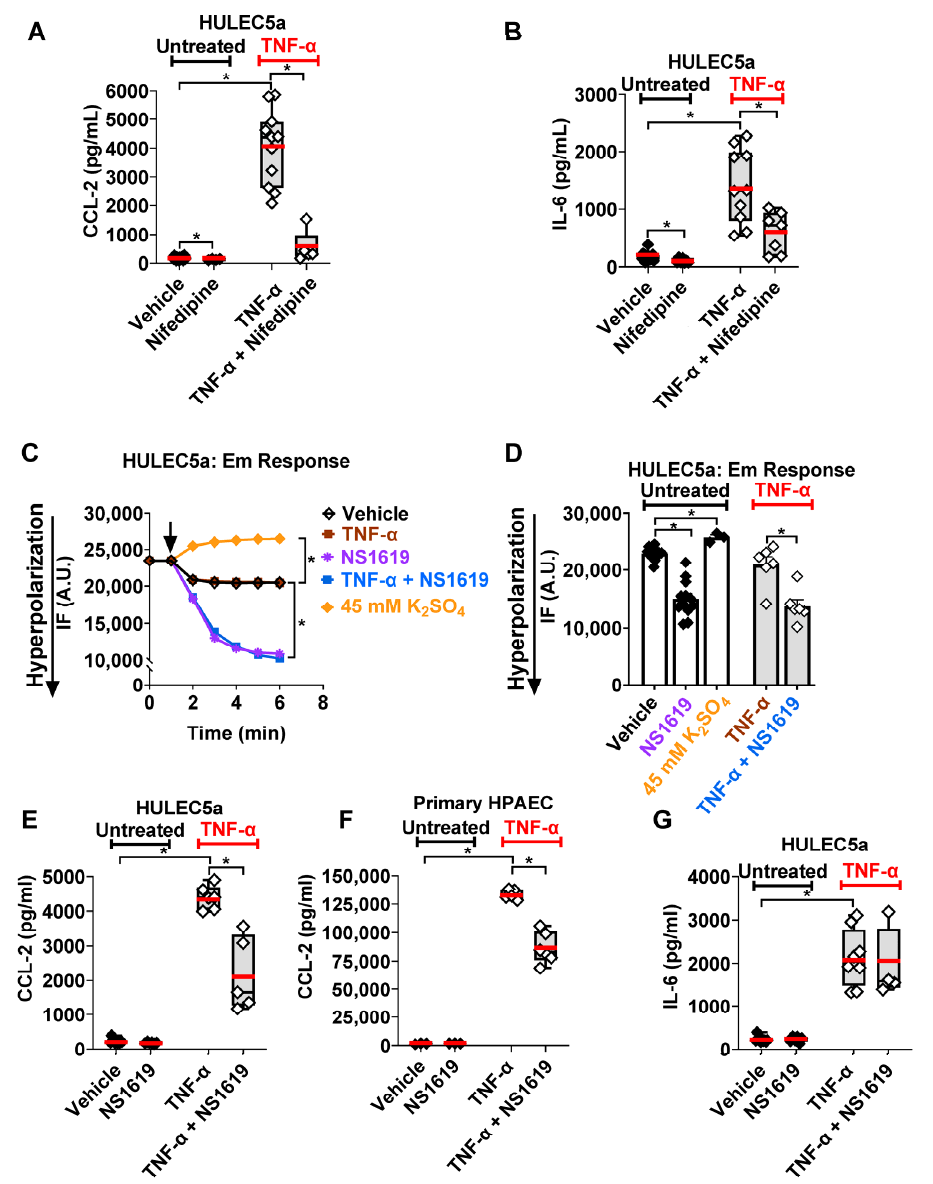
Figure 1. Effects of Ca V channel inhibition with Nifedipine and the selective BK channel opener NS1619 on inflammatory cytokine secretion: ( A , B ). The inhibition of L-type Ca V channels with Nifedipine (10 µ M; 24 h) decreases the baseline and TNF- α -induced (5 ng/mL; 24 h) CCL-2 and IL-6 secretion from HULEC5a cells ( n = 5–20, * p ≤ 0.05), shown by ELISA. ( C , D ) Fluorescence intensity (IF; A.U. = arbitrary units) measured by fluorometric FLIPR assays depicts Em changes in HULEC5a cells: ( C ) A representative recording, showing NS1619-induced (30 µ M; 5 min) Em hyperpolarization (decrease in IF), which persists even after TNF- α treatment (5 ng/mL; 5 min). TNF- α itself did not alter the Em. As an internal control, we induced Em depolarization with 45 mM K 2 SO 4 . ( D ) Summary of n = 6 individual FLIPR experiments; * p ≤ 0.05. ( E , F ) Em hyperpolarization with NS1619 (30 µM; 24 h) decreases CCL-2 secretion from human pulmonary microvascular endothelial (HULEC5a) and primary human pulmonary artery endothelial (HPAEC) cells when stimulated with 5 ng/mL or 25 ng/mL of TNF- α , respectively, shown by ELISA. ( G ) Em hyperpolarization with NS1619 (30 µ M; 24 h) does not change TNF- α -induced (5 ng/mL; 24 h) IL-6 secretion from human pulmonary endothelial cells (HULEC5a), shown by ELISA. Baseline CCL-2 and IL-6 secretion are not affected by NS1619 treatment ( n = 4–11, * p ≤ 0.05). n = number of separate cell passages, which are considered biological